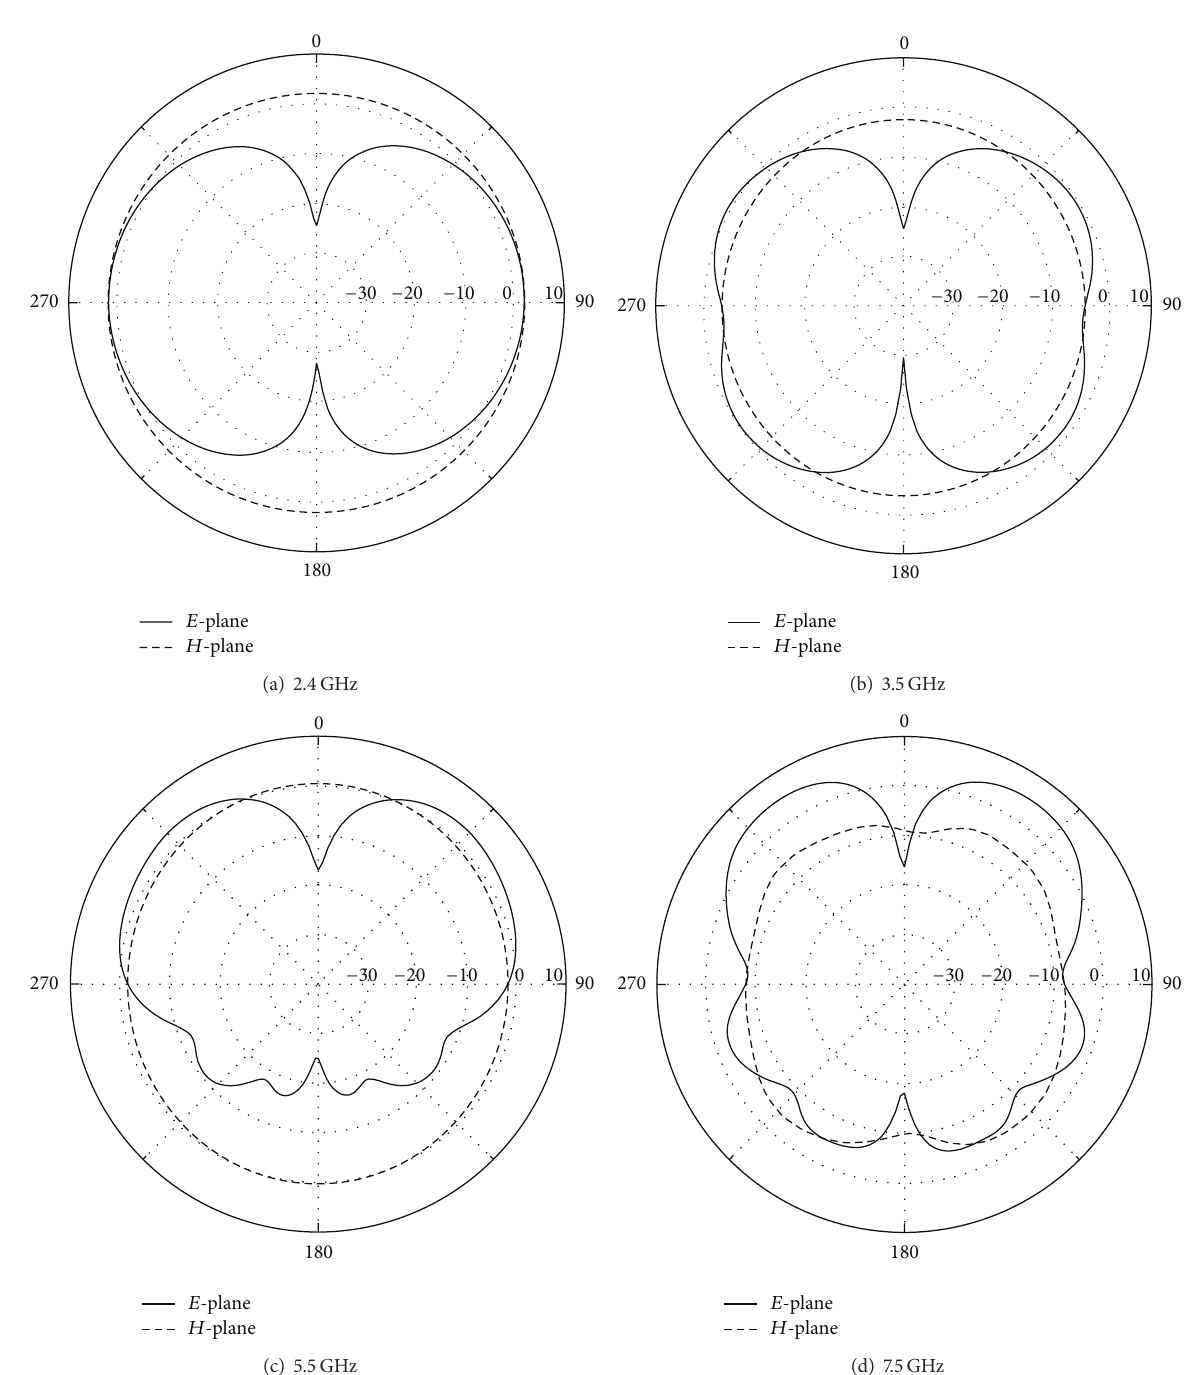
Figure 8: Simulated gain patterns in the E -plane ( phi = 90 degree ) and H -plane for the proposed antenna at the frequency of (a) 2.4 GHz, (b) 3.5 GHz, (c) 5.5 GHz, and (d)